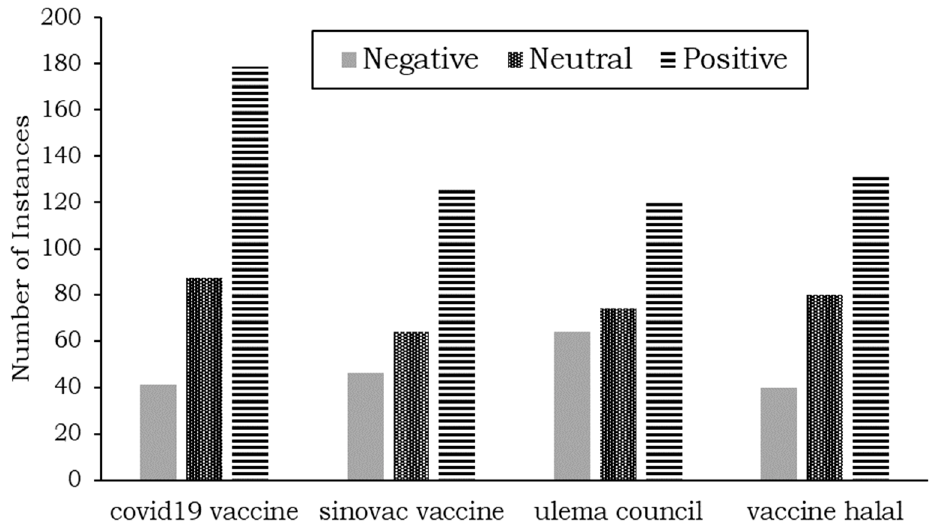
Figure 8. Aspect-based sentiment analysis results for Facebook posts.